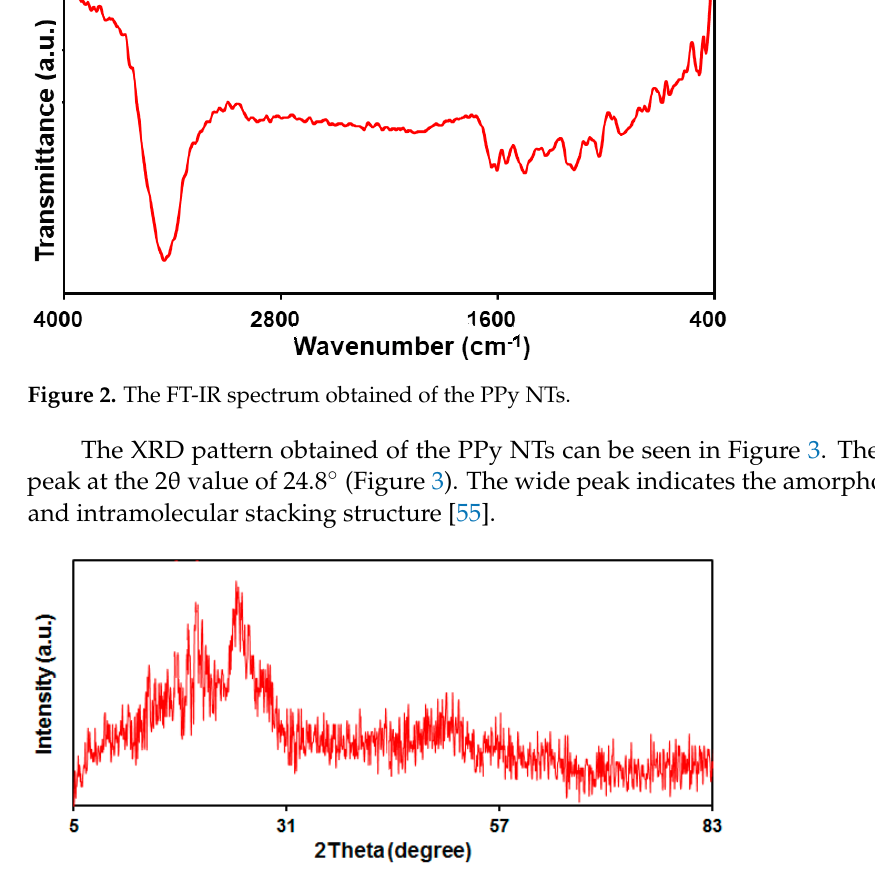
Figure 3. XRD pattern of the PPy NTs.